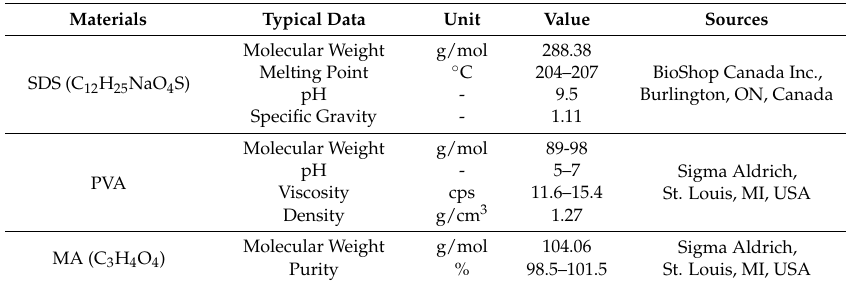
Table 4. Other chemicals used in this work and their properties.